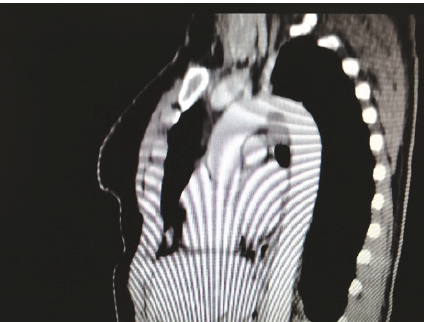
Figure1:Coronalandaxialviewofaorticarchdepictedthepresence of thrombus in a calcified lesion.